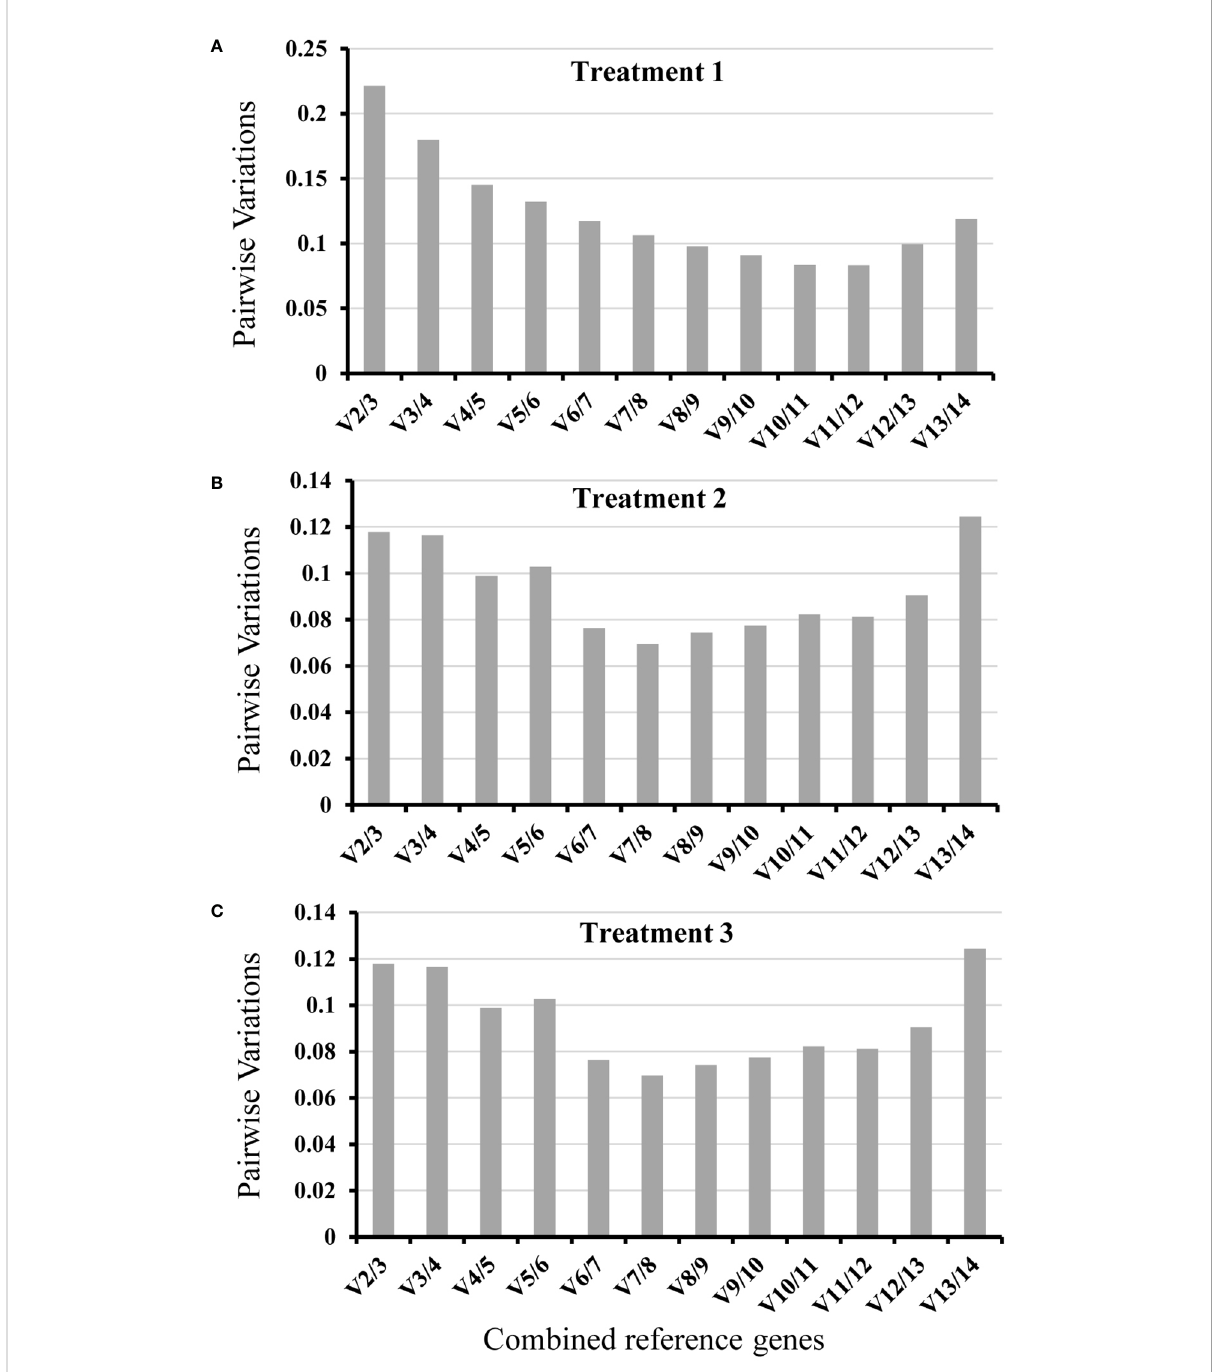
FIGURE 4 Pairwise variation (V) of candidate reference genes calculated by geNorm. The Vn/Vn+1 value calculated re fl ecting gene expression stability of thirteen candidate reference genes in three different treatments. (A) , Treatment 1: root knot samples caused by M. incognita ; (B) , Treatment 2: whole root infected by M. incognita ; (C) , Treatment 3: whole root treated by Pseudomonas